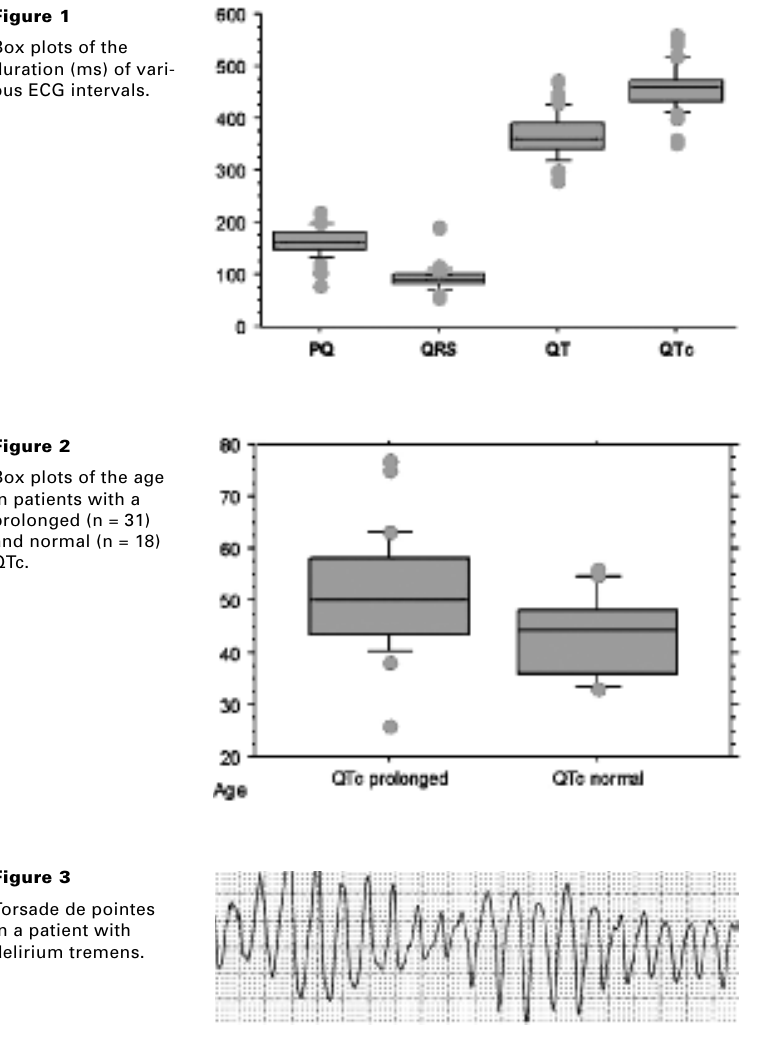
Figure 1 Box plots of the duration (ms) of vari- ous ECG intervals.